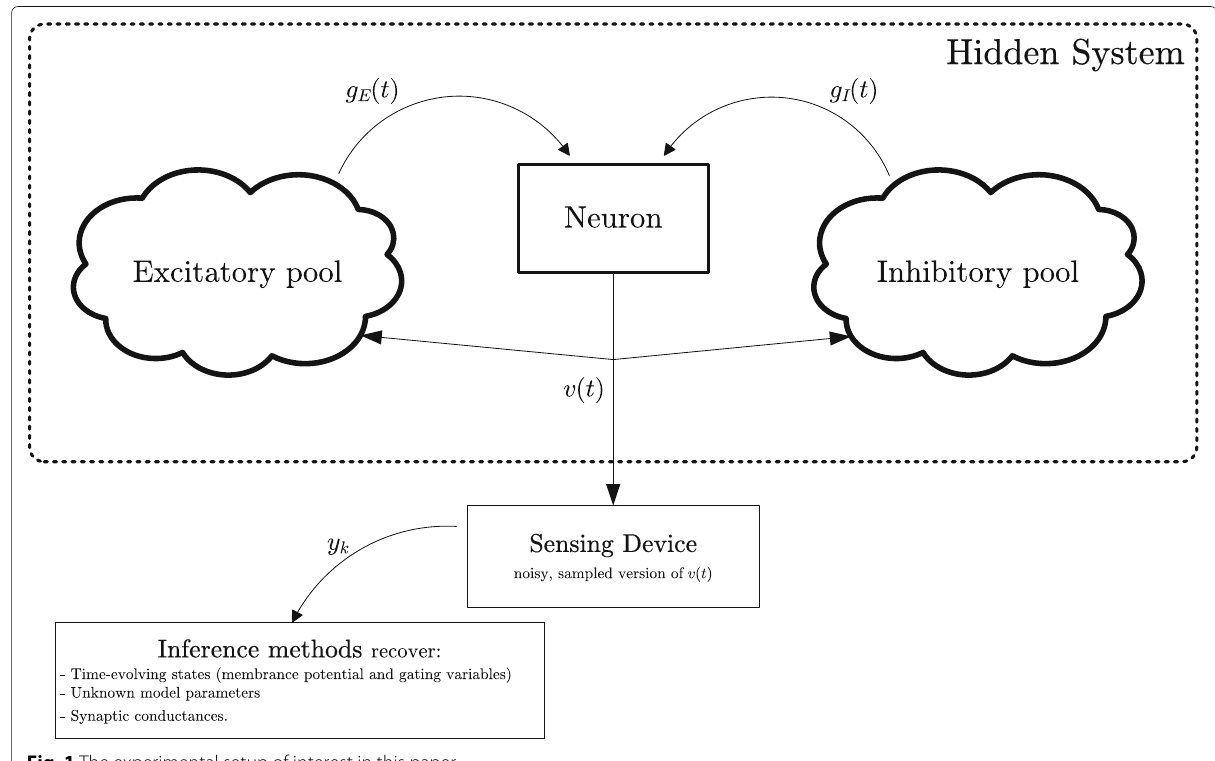
Fig. 1 The experimental setup of interest in this